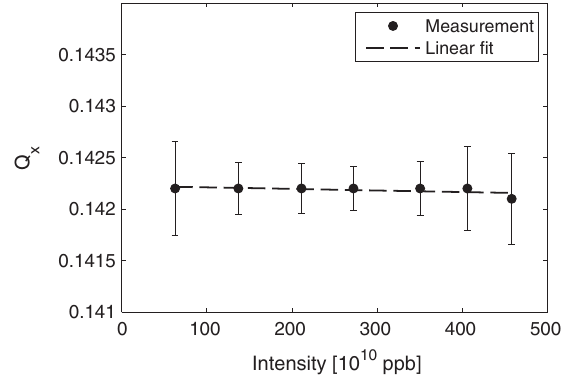
FIG. 2. Horizontal tune shifts with beam intensity measured at 25.48